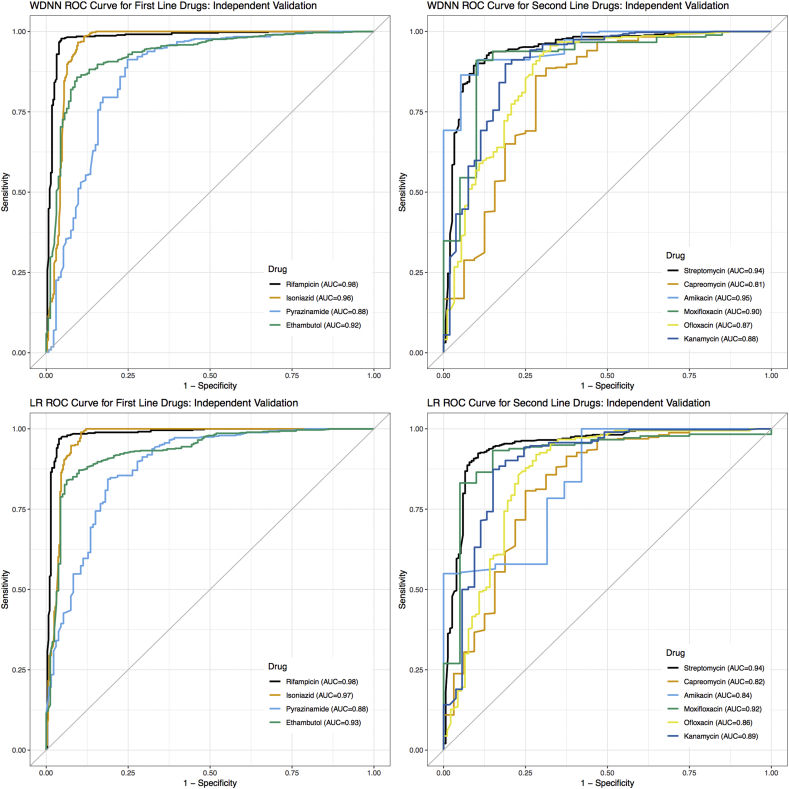
Tuberculosis drug resistance ROC performance curve of the MD-WDNN and logistic regression. A ROC plot of MD-WDNN (top) and logistic regression (bottom) predictive performance on the independent validation set for first-line (left) and second-line (right) anti-tuberculosis drugs.